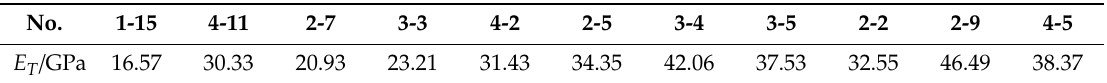
Table 6. Table of total elastic modulus.